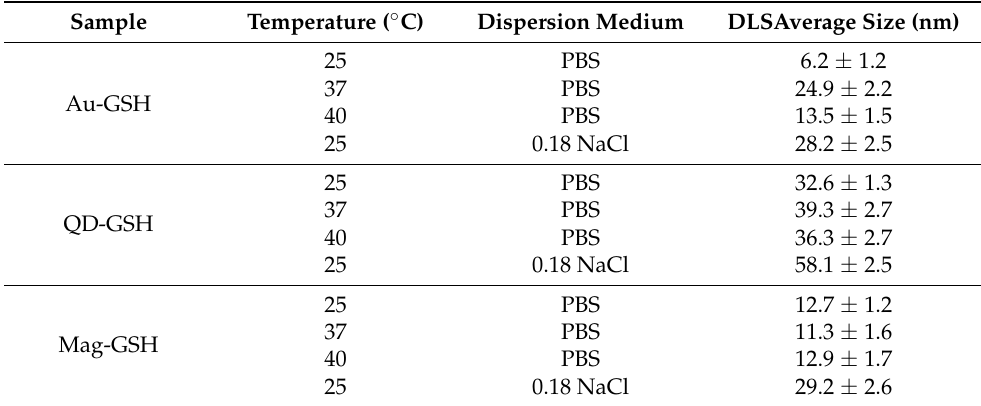
Table 2. Z-potential values obtained for gold and magnetic-iron-oxide NPs capped with CYS and with GSH at 25 °C and in PBS solution.